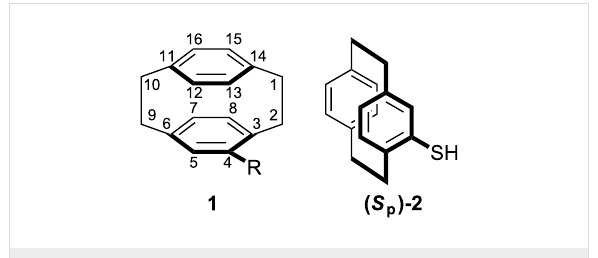
Figure 1: [2.2]Paracyclophane ( 1 ) showing standard numbering and [2.2]paracyclophane-4-thiol ( 2 ).